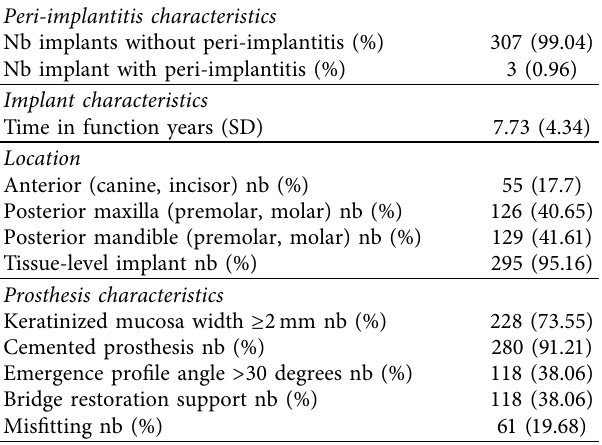
Table 3: Implant and prosthesis characteristics. Peri-implantitis